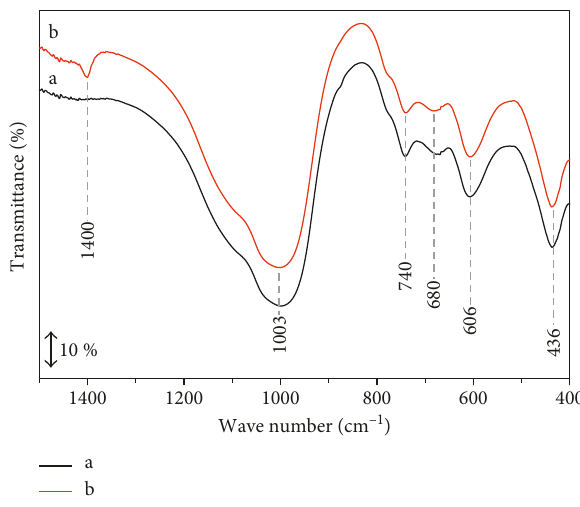
Figure 4: FTIR spectra of Al-waste-NaP1 (a) before and (b) after NH 4+